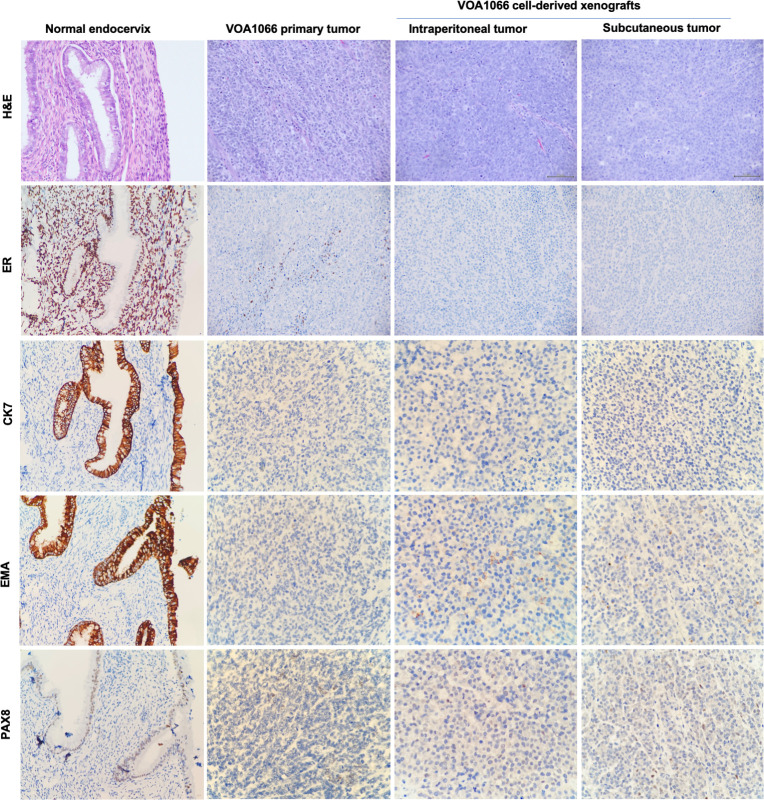
H&E and ER IHC staining of VOA1066 samples.Both the primary tumor and xenografted subcutaneous and intraperitoneal tumors of VOA1066 showed minimal focal or no staining of Mullerian epithelial markers ER, CK7, EMA and PAX8.